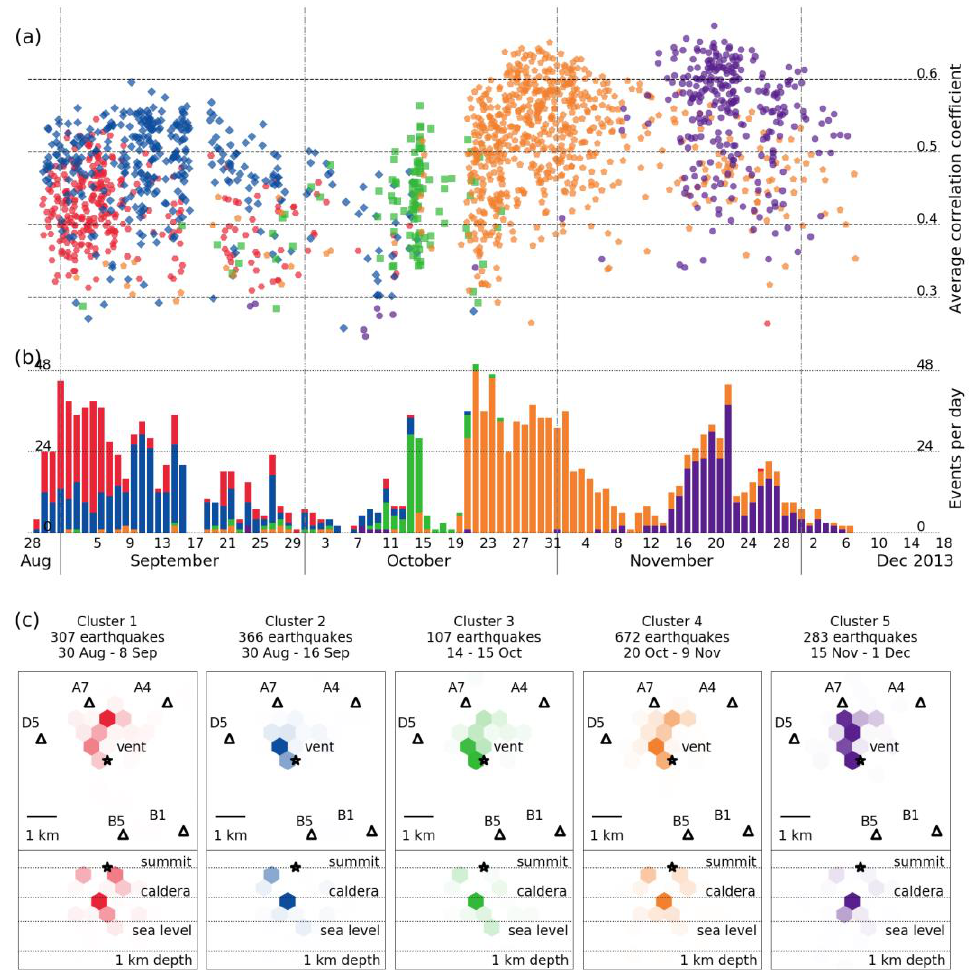
Figure 8. Cluster analysis results for BP based catalog. In all panels, the different colors indicate five identified clusters. ( a ) Average correlation coefficients for the final distribution after the 3rd iteration with five sequential clusters. ( b ) A daily number of events for different clusters. Note that each cluster has a dominant period with a maximum number of events per day. ( c ) Hexagonal plots of the events space distribution for each cluster projected to map view (upper row) and to vertical section oriented in west-east direction (lower row). Each hexagon presents confidence area of the location, while color intensity reflects normalized number of the events in this location.